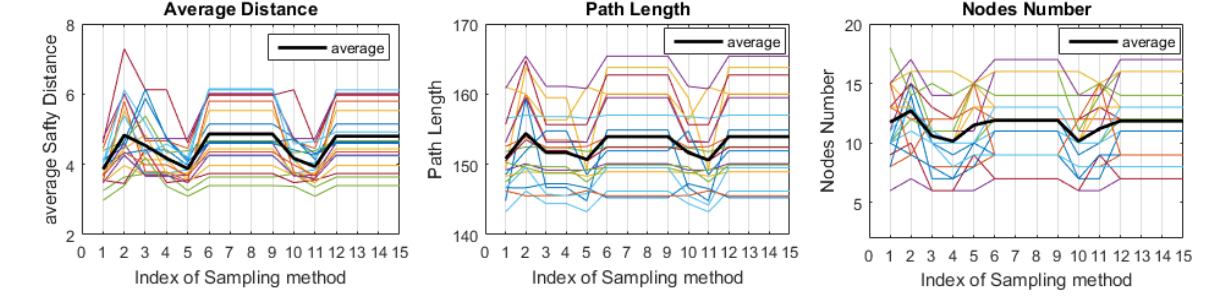
Figure 20. Comparison of the smoothing results of different schemes. Table 1. Effect of the sampling method on smoothing results.